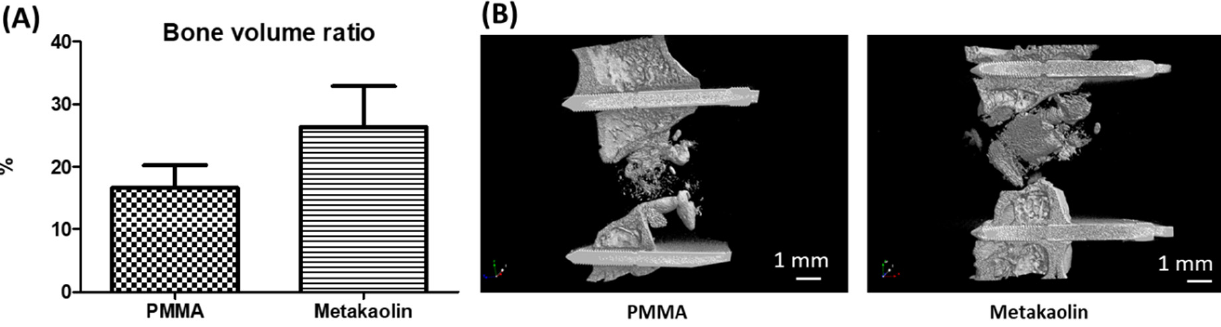
Figure 6. Bone formation was assessed by microCT. ( A ) The quantitative and comparative analysis showed no difference in bone volume between the metakaolin and PMMA groups. ( B ) Representative three-dimensional reconstructions of the region of interest in the two